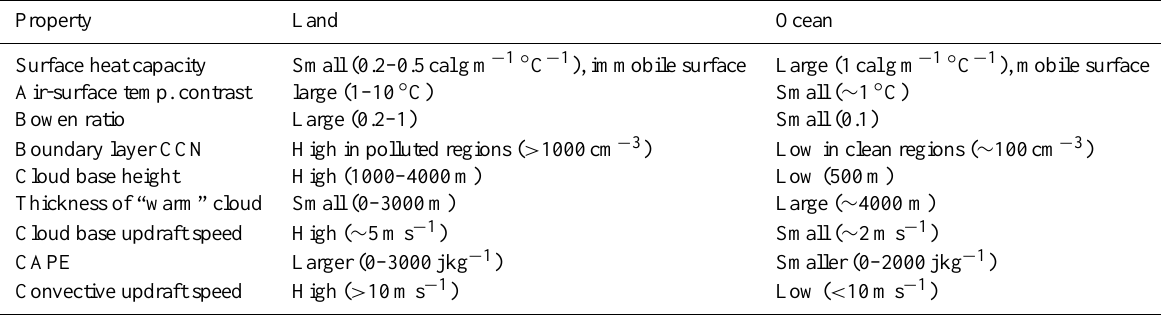
Table 3. Contrast in land–ocean physical and meteorological properties.